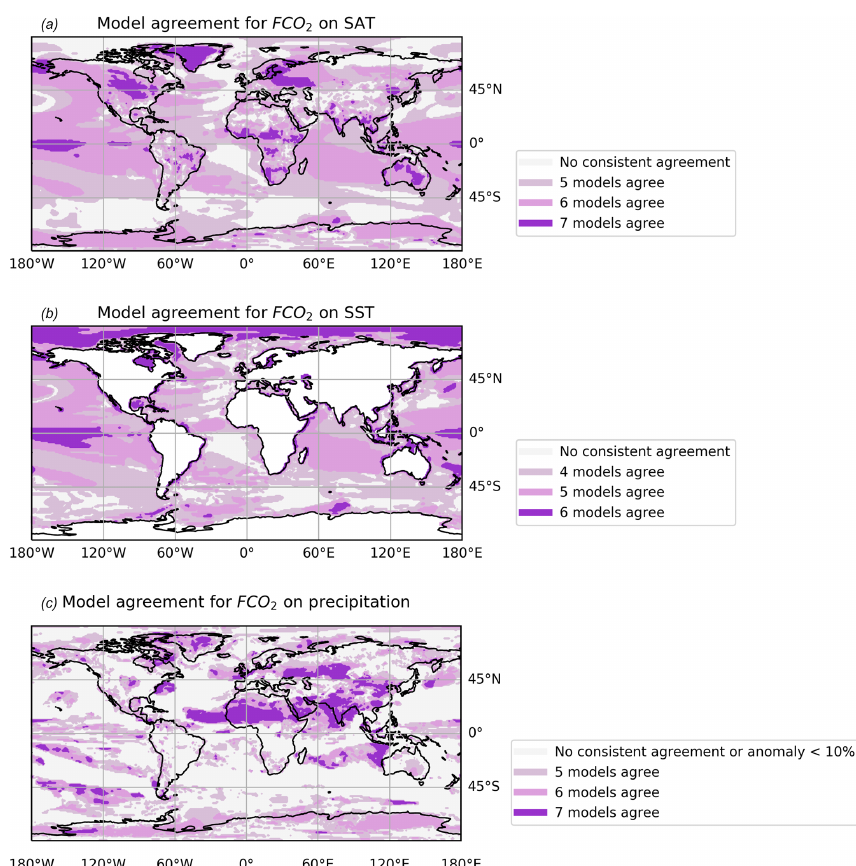
Figure 7. The level of agreement between models included in the FCO 2 analysis, showing where models agree on the dominant forcing shown by the FCO 2 method (i.e. whether FCO 2 > 0 . 5 or FCO 2 < 0 . 5). All seven models (CCSM4-UoT, CESM2, COSMOS, HadCM3, IPSLCM5A2, MIROC4m, and NorESM1-F) are included for the SAT and precipitation analysis; IPSLCM5A2 is excluded from the SST analysis, as only 10 model years of data were available – hence, a maximum of six models in agreement for SST. For precipitation, agreement is only assessed in regions where the Eoi 400 –E 280 precipitation anomaly is greater than 10% for